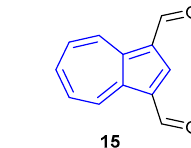
Figure 11. Fluorescent azulene aldehydes synthesised by Li, Gao and co-workers [58] .